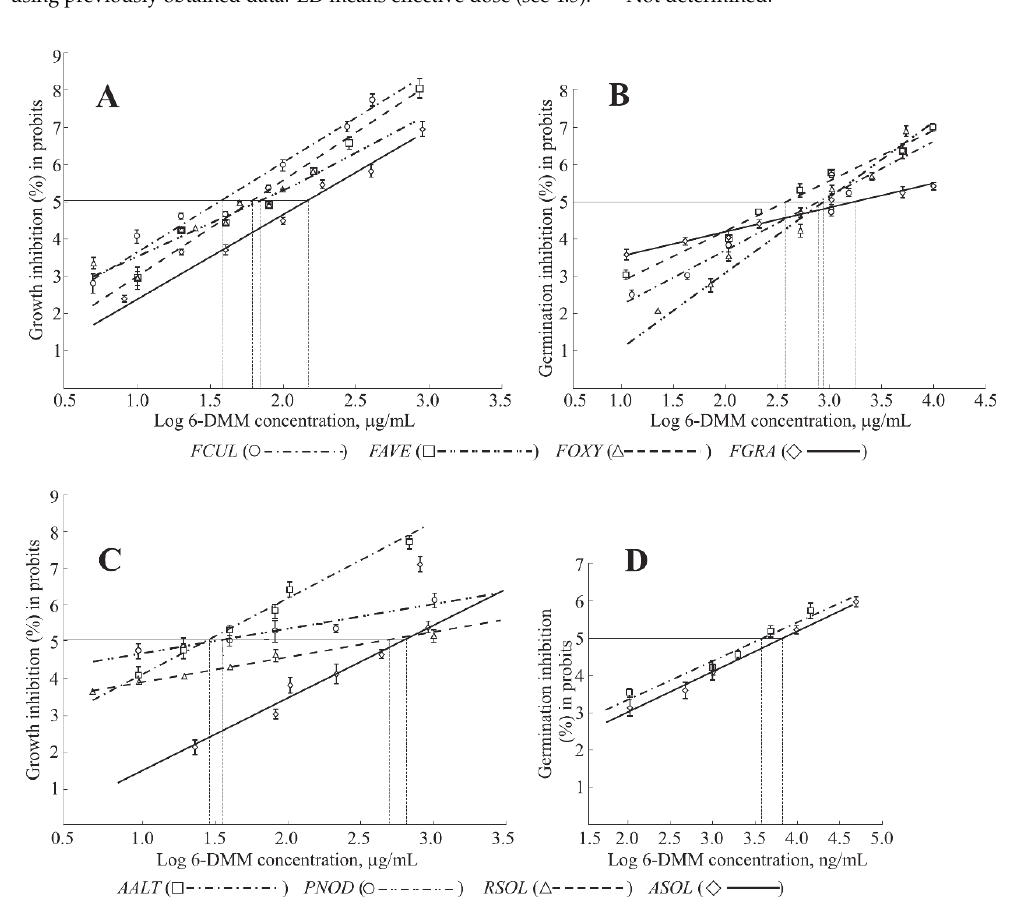
Figure 2. Dose-response curves showing inhibitory effect of 6-DMM on the growth ( A , C ) and germination ( B , D ) of various plant pathogenic fungi. FCUL, Fusarium culmorum ; FAVE, F. avenaceum ; FOXY, F. oxysporum ; FGRA, F. graminearum ; AALT, Alternaria alternata ; PNOD, Parastagonospora nodorum ; ASOL, A. solani ; RSOL, Rhizoctonia solani . Vertical dotted lines cross the X -axis at the points corresponding to LogED 50 for each of pathogens. Bars on the graphs ( A – D ) indicate SD and SE, respectively. The markers correspond to logarithms of the tested 6-DMM